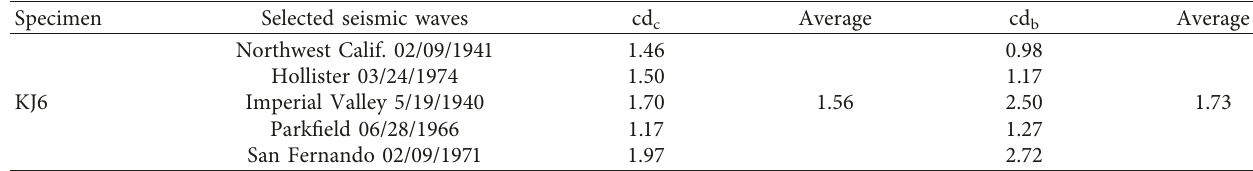
Table 17: Maximum curvature ductility coefficients of beams and columns in model KJ6.